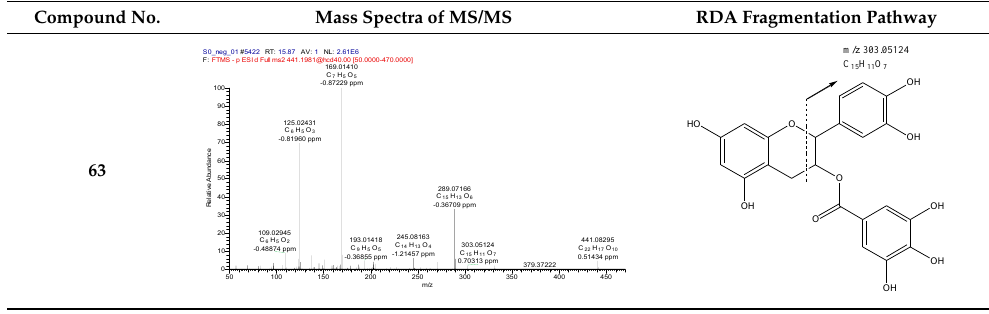
Figure 5. Structure of ursane-type ( 67 , 72 , 79 , 88 ) and oleanane-type ( 68 , 77 , 81 , 86 , 90 ) pentacyclic triterpene. This figure is fuzzy, please replace it with sharper figure.